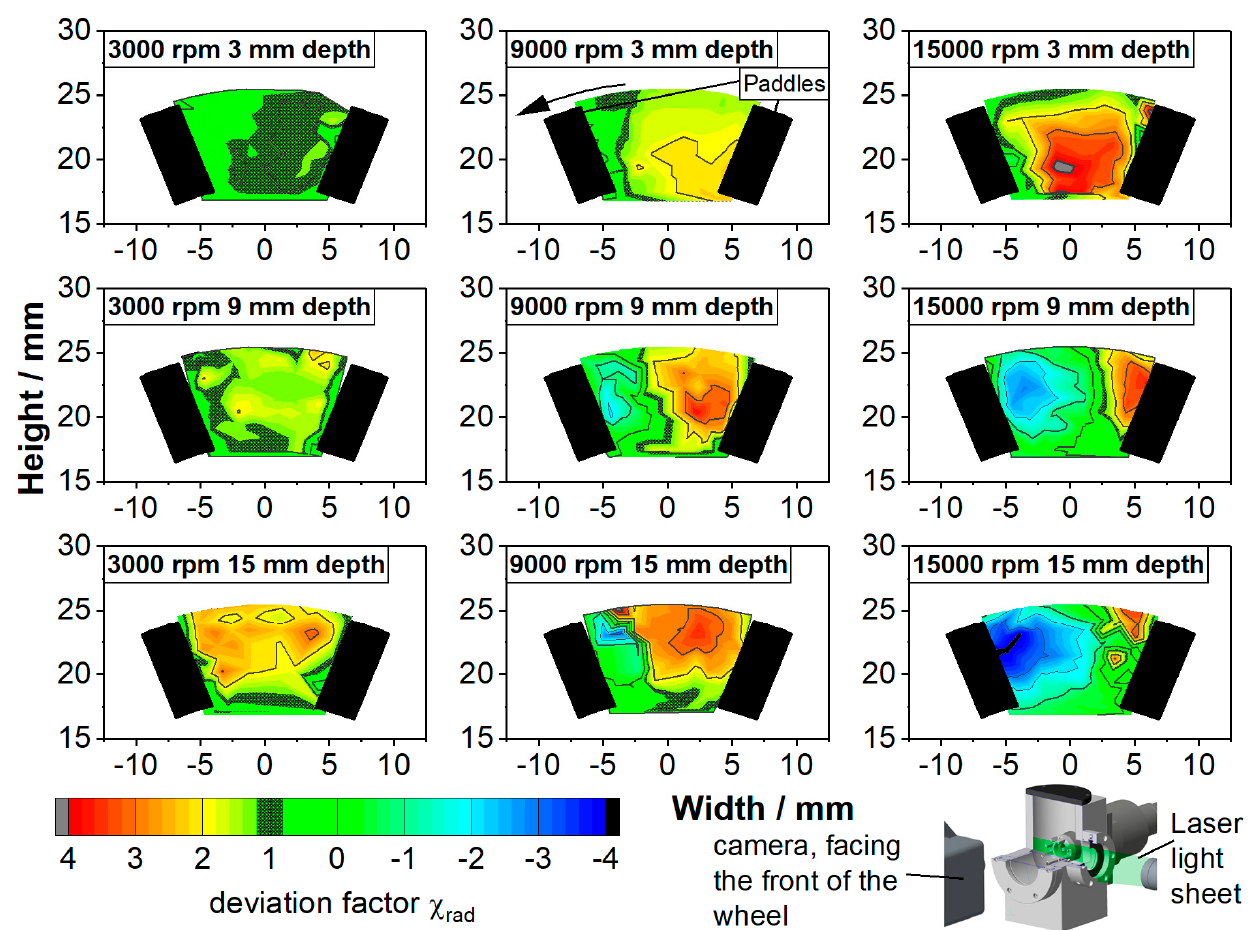
Figure 5. Measured radial air velocity ( v rad,meas ) divided by theoretically assumed, inwardly directed v rad,undisturbed (deviation factor χ rad ) at different rotor speeds and depths behind the front glass panel. The black areas indicate the deflector wheel paddles, rotating counterclockwise. In the measurement, the laser light sheet was facing the side, while the camera faced the front. For better visibility, the result was turned by 90°. The black dotted region between the blades indicates a deviation factor of 1 ± 20%, meaning only for this small region the usually assumed radial air velocity approximately equals the air velocity calculated from mass balance and flow-through area.